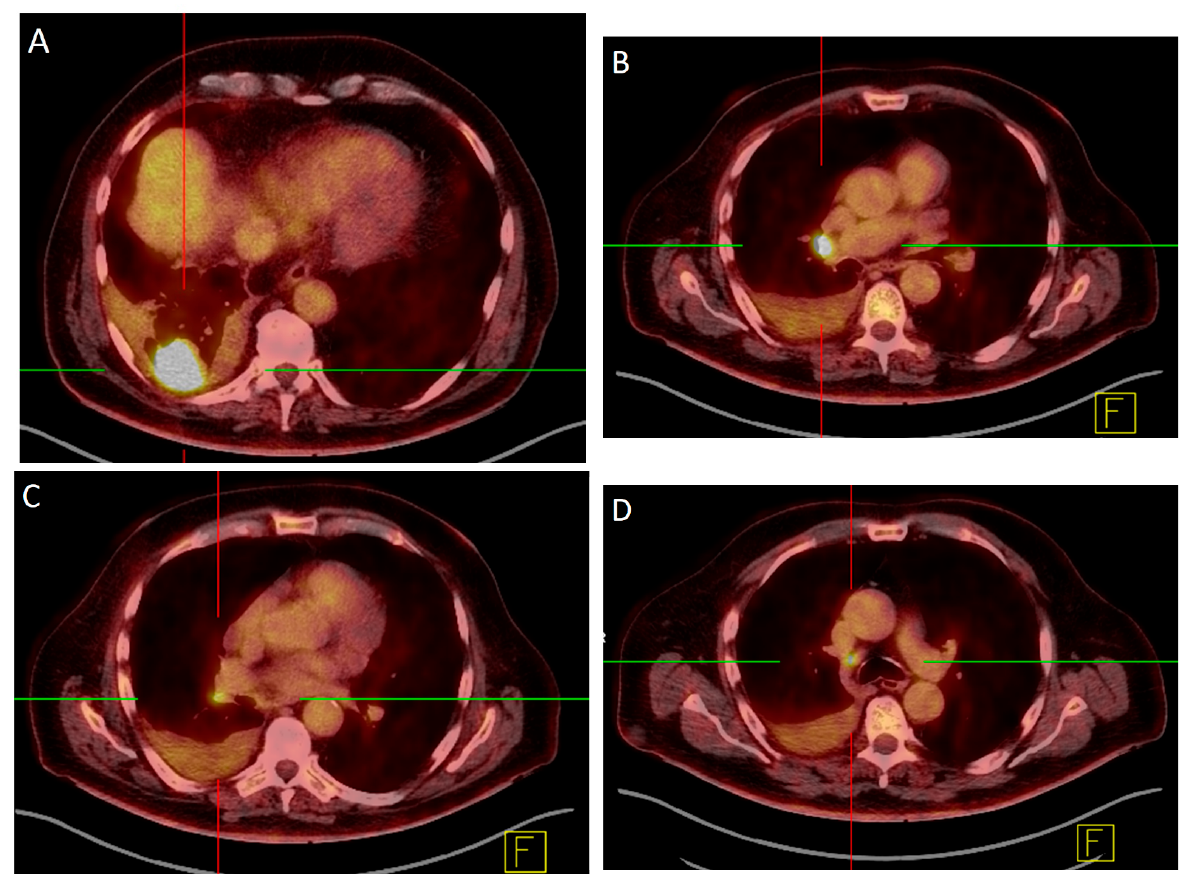
Figure 1. 78-year-old male with a histologically proven adeno carcinoma in the right lower lobe ( A ). The left hilar region showed involvement in the EBUS region 10R ( B ) but not 11R ( C ). An additional lymph node in the region 4R ( D ) was positive as well. All fi ndings were con fi rmed histologically.